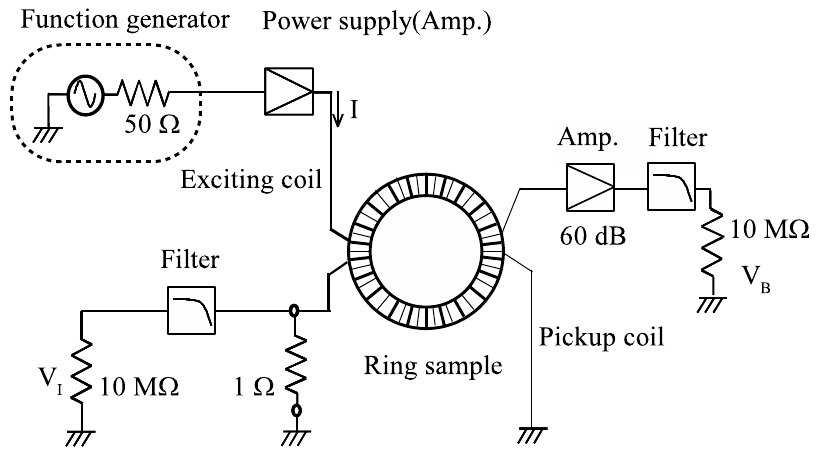
Figure 2. Schematic diagram of electric circuit for minor loop measurements.